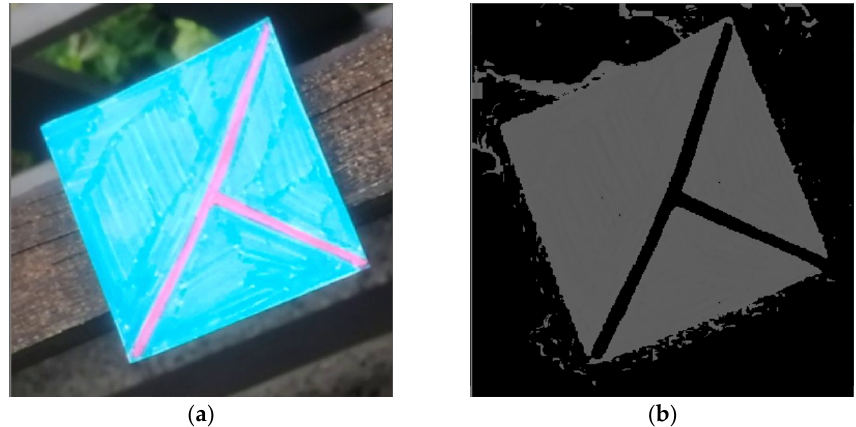
Figure 24. ( a ) cropped marker from the detected area of the original image. ( b ) image after filtering out pixels without the most common hue.